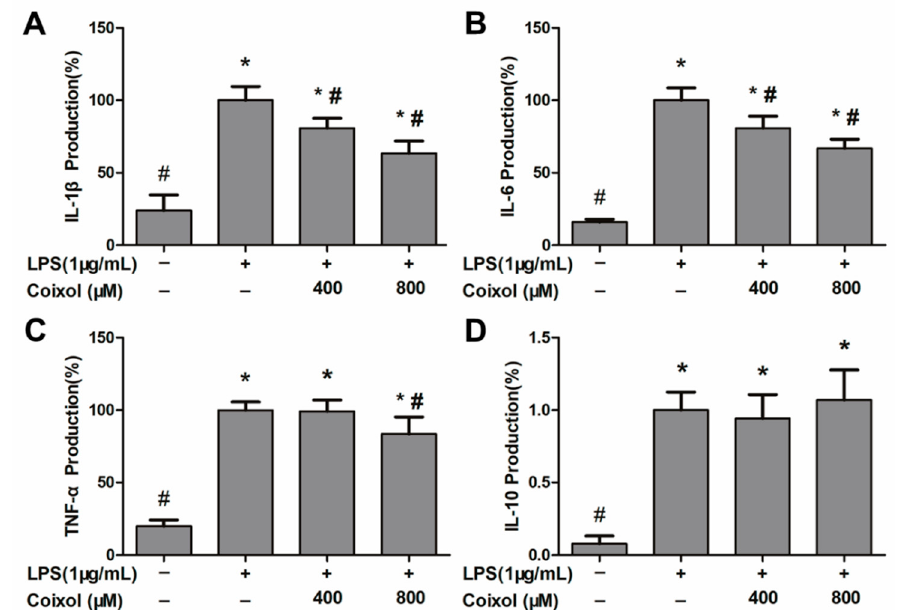
Figure 2. Effects of coixol on the production of cytokines in LPS-induced RAW 264.7 cells supernatant. Cells were pretreated with coixol for 4 h and then stimulated with 1 μ g/mL LPS for 4 h. The productions of ( A ) interleukin (IL)-1 β , ( B ) IL-6 and ( C ) tumor necrosis factor (TNF)– α and ( D ) IL-10 . Cytokine productions were measured using an ELISA Kit. The data represent the mean ± SD ( n = 6). * p < 0.05 vs. control group. # p < 0.05 vs. LPS group.